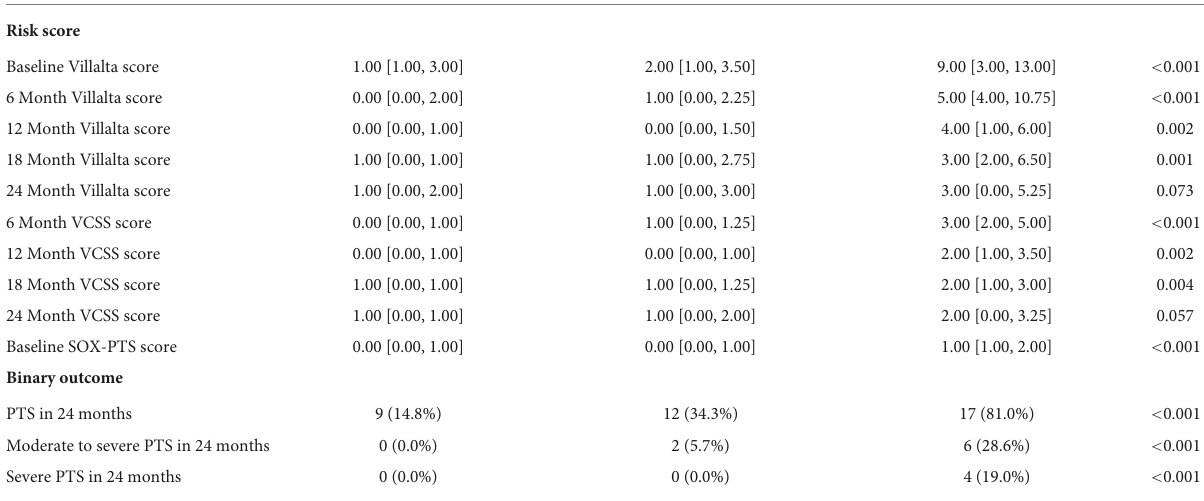
TABLE 3 Outcome in each risk groups defined by prediction probability of the XGBoost model in external validation cohort. Outcome Low-risk group ( n = 61) Intermediate-risk group ( n = 35) High-risk group ( n =